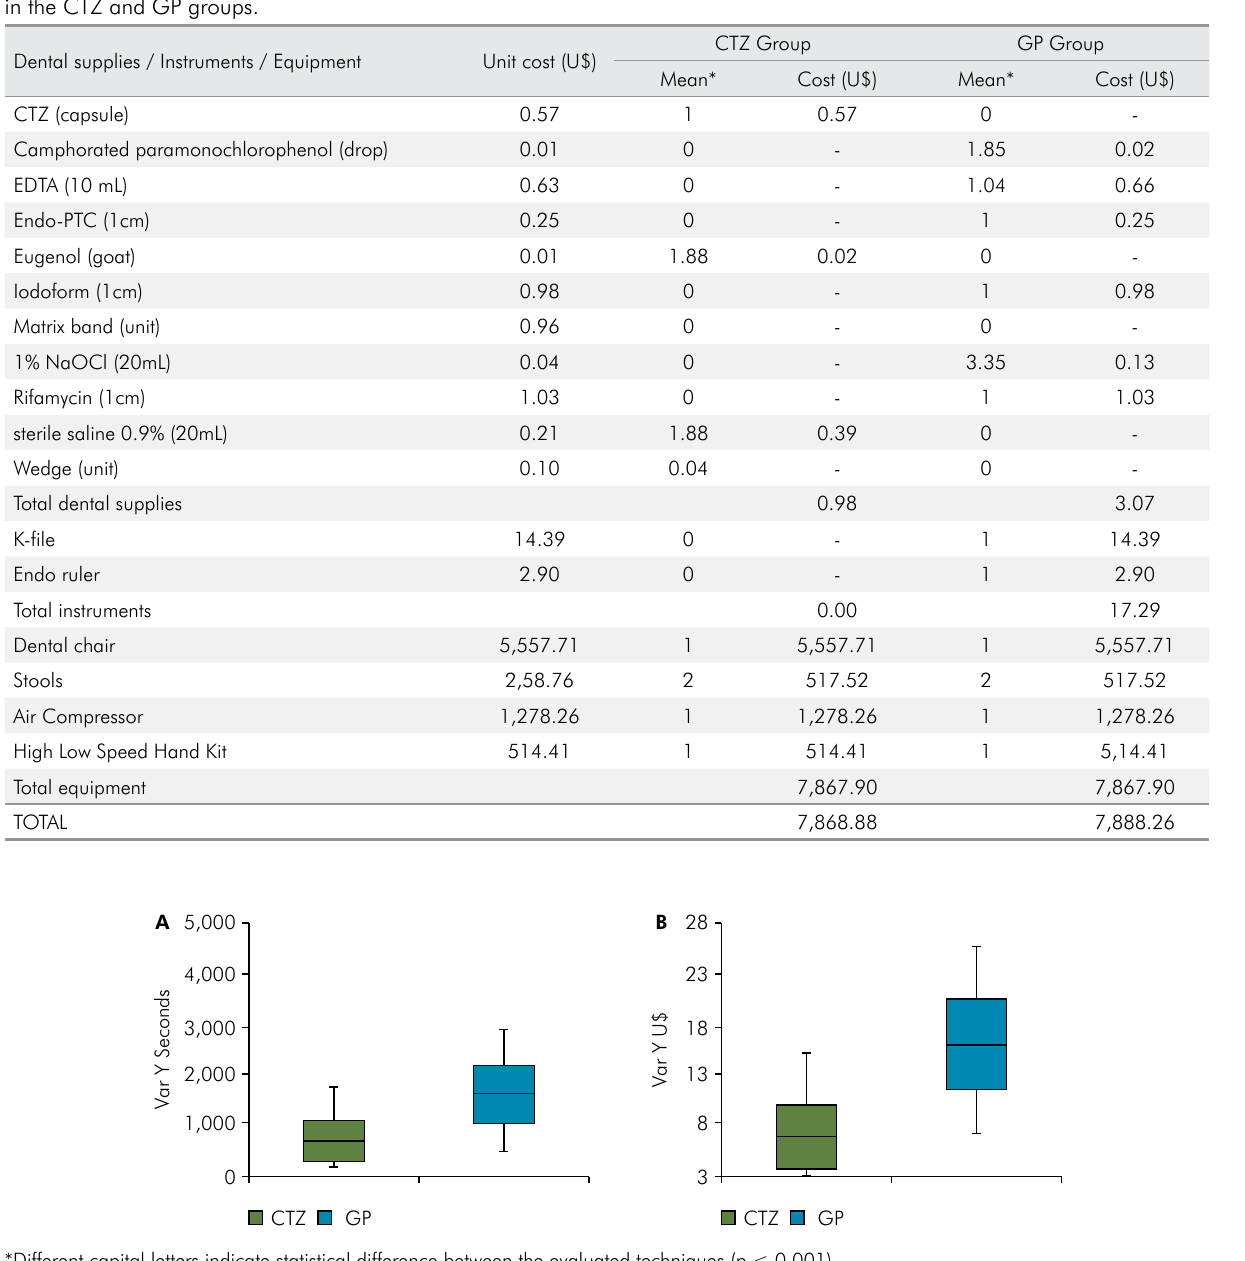
Figure 2. Boxplot chart of treatment time (a) and total cost (b) amongst the two groups evaluated (CTZ; GP) (p <